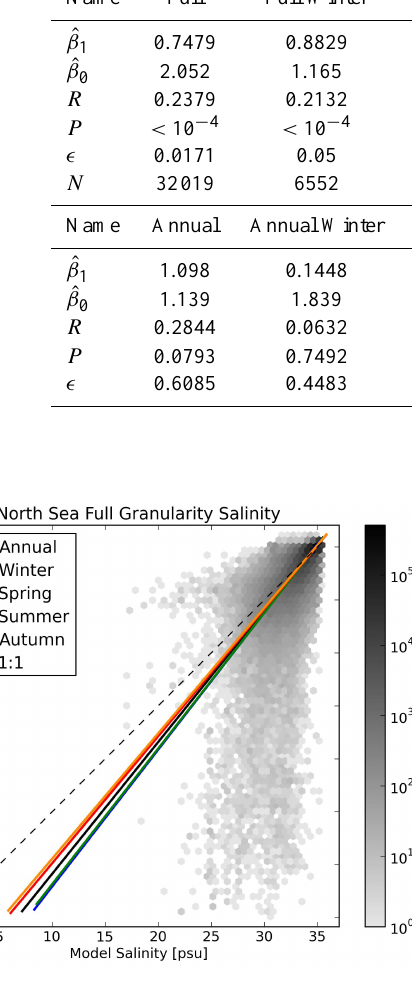
Fig. 4. Two-dimensional binned scatter plot of full granularity matched model data against in situ measurements for the North Sea salinity. The solid coloured lines show the linear regression fits for the full annual and seasonal data, and the dashed line is the line of unity slope that passes through the origin. The shading of the binned data density plot is scaled such that darker hue indicates logarithmi- cally higher data density.